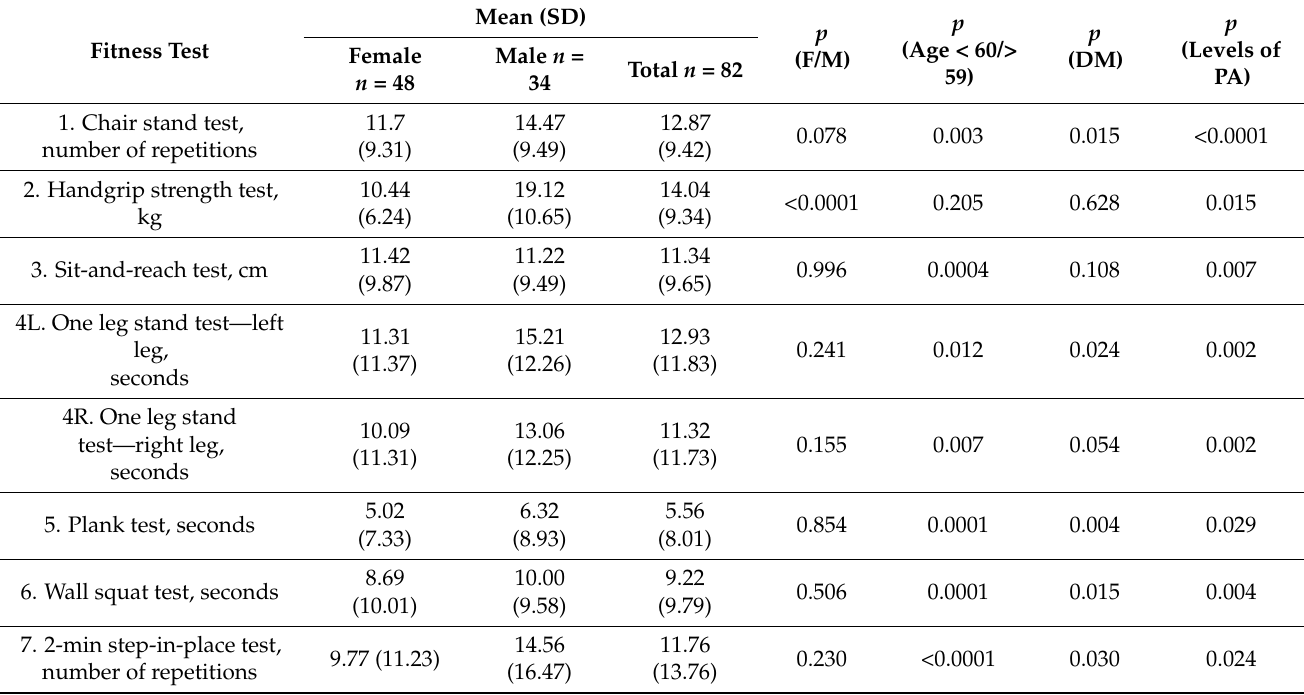
Table 4. Differentiation in the results of fitness tests by gender, age, the presence of DM, and the current level of PA of the participants (with the Mann–Whitney U test and the Kruskal–Wallis test for levels for PA differentiation).